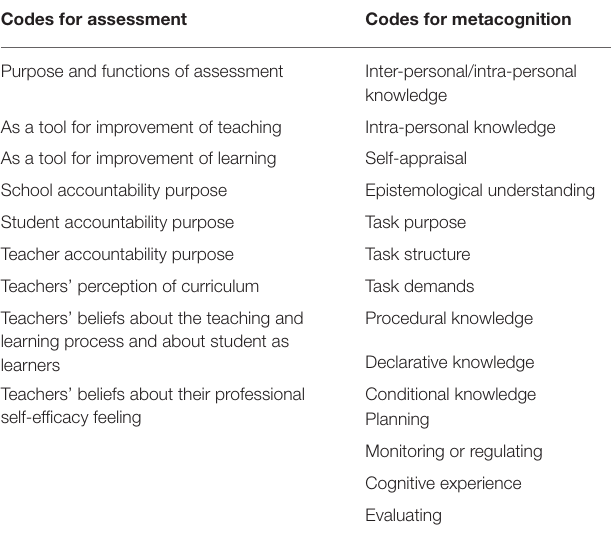
TABLE 2 | Coding scheme for RQ1 and